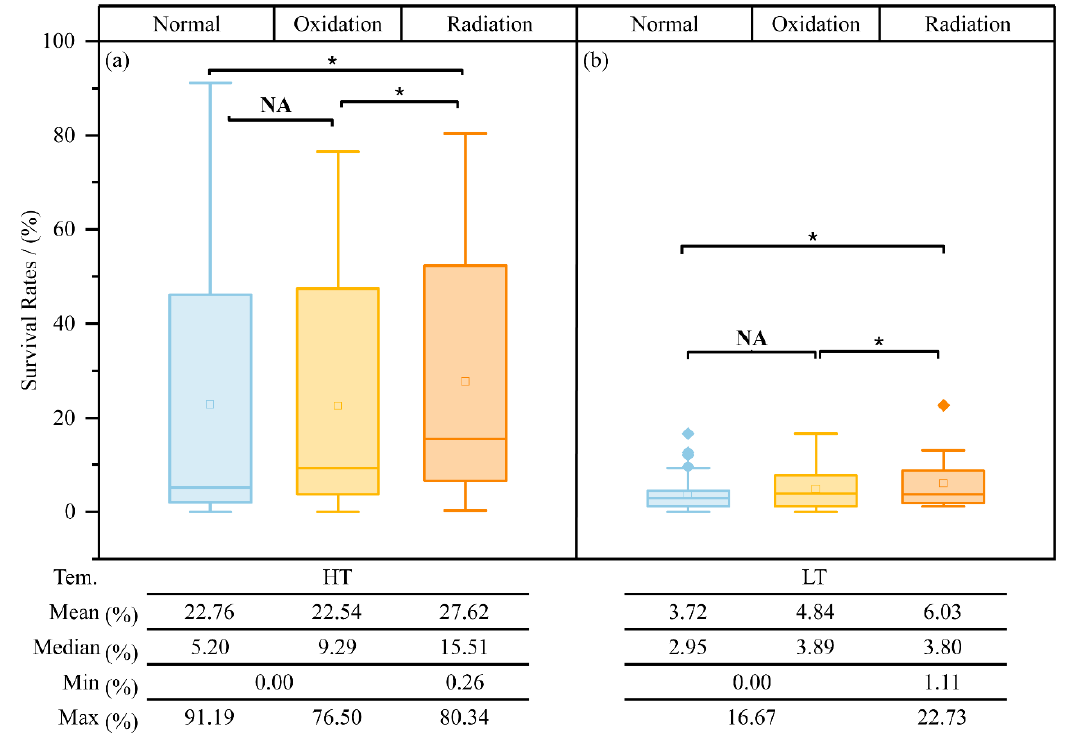
Figure 8. Assessment of resistance to 100-J/m 2 UV-C radiation in strains isolated from samples with different pre-treatments at HT ( a ) and LT ( b ). NA, no significant correlation; asterisks (*), significant difference ( p < 0.05).